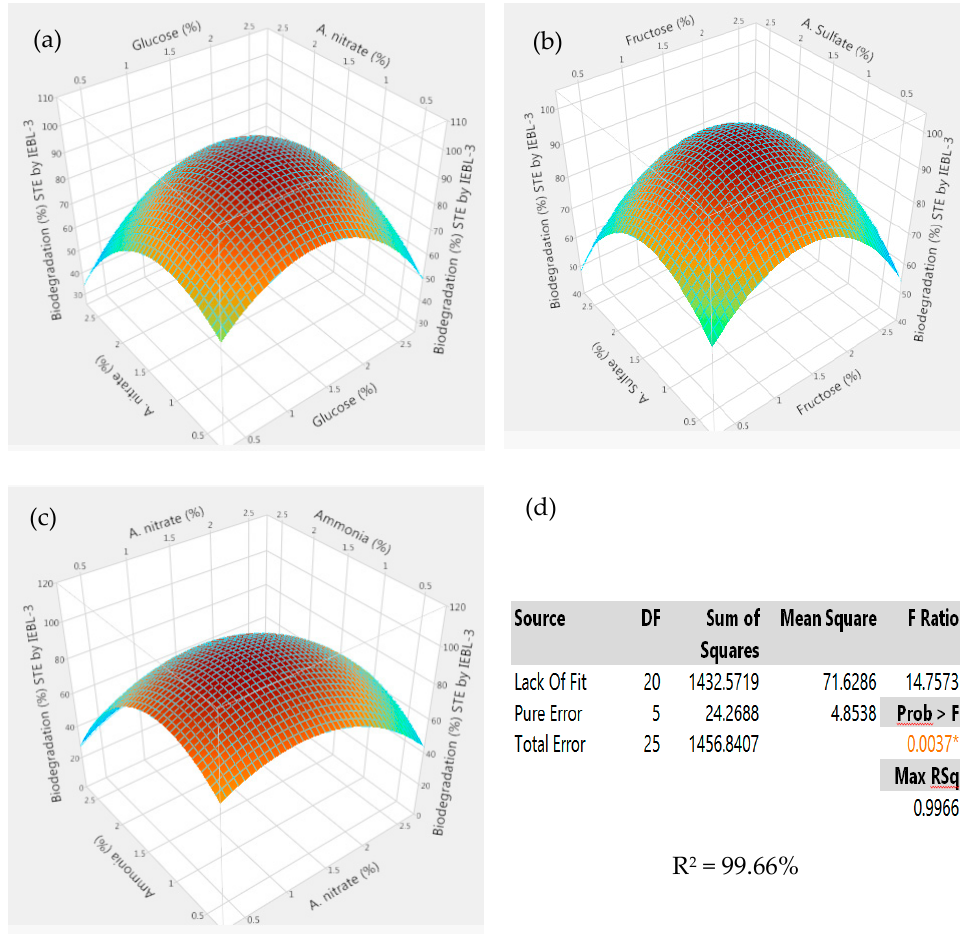
Figure 5. Response surface 3D graphs showing effect of carbon and nitrogen sources on the biodegradation of Sitara Textile (MT) industrial effluent by P. betulinus IEBL-3; graphs represent positive interaction between ( a ) ammonium nitrate and glucose, ( b ) ammonium sulfate and fructose and ( c ) ammonia and ammonium nitrate. ( d ) Statistical analysis indicating the significant effect of parameters (* indicate significance of value).